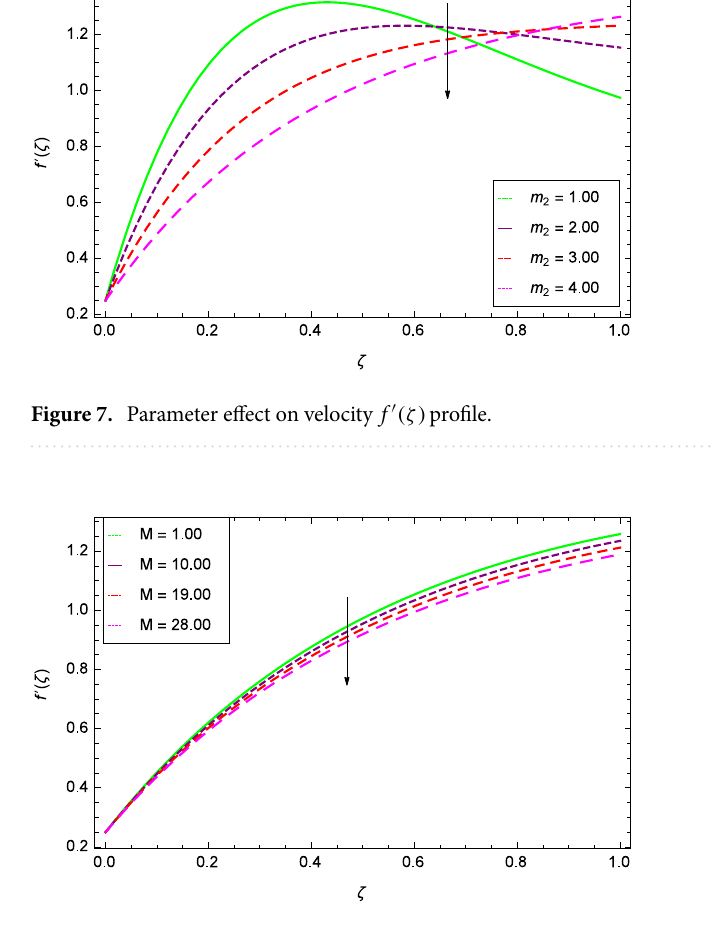
Figure 8. Parameter effect on velocity f ′ (ζ) profile.